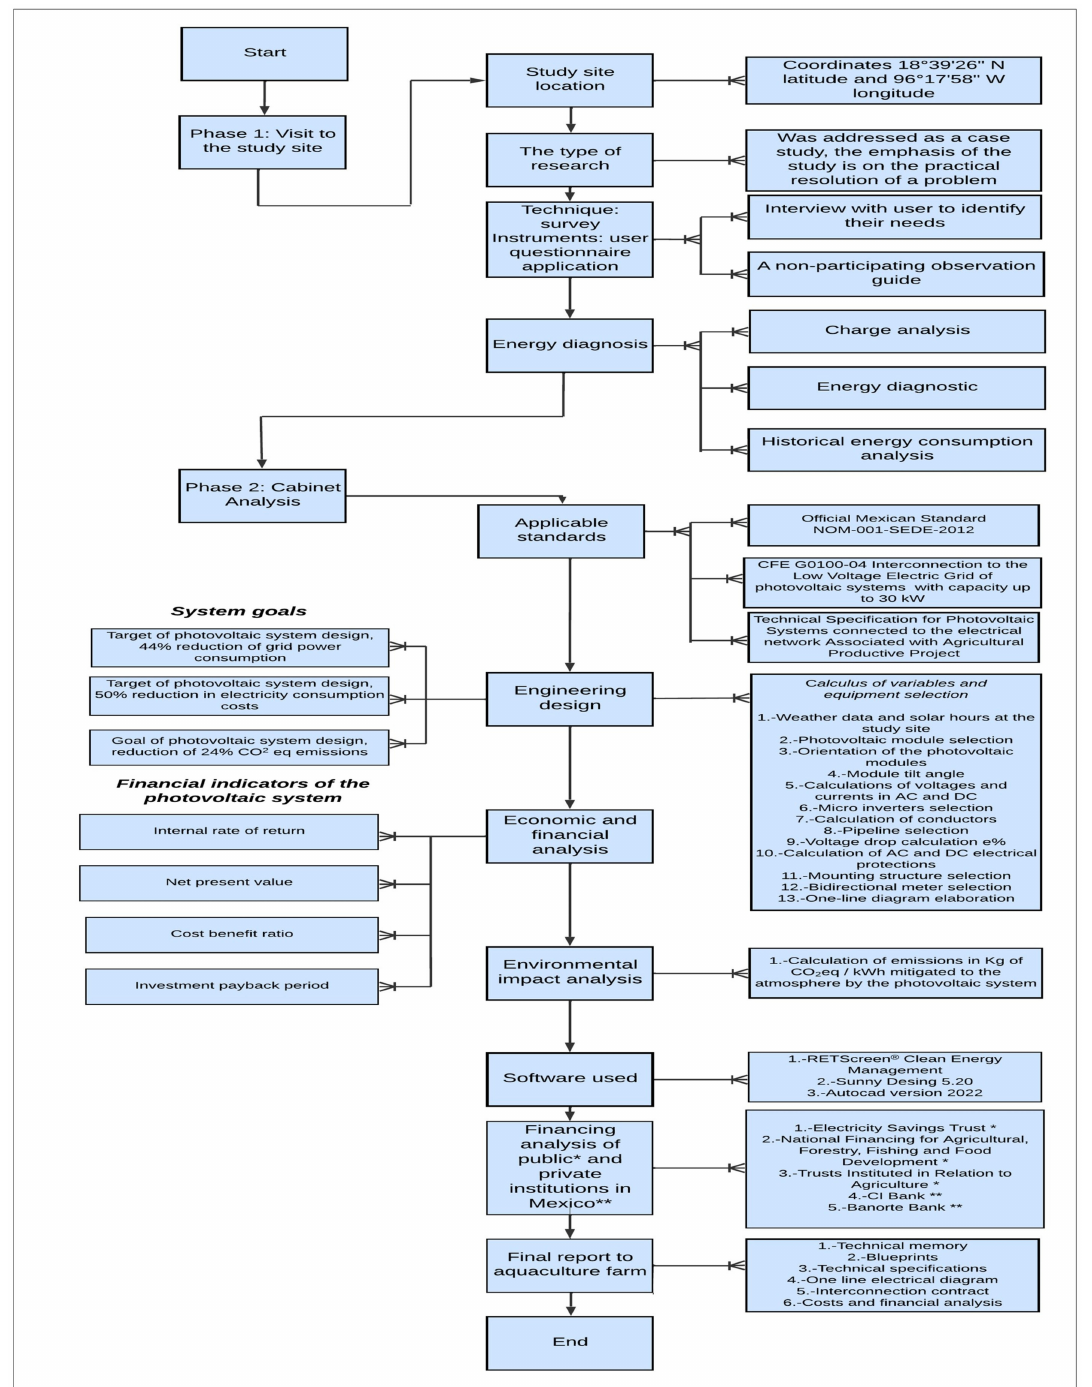
Figure 7. Applied methodology for the development of the research. Public financing *, Private financing